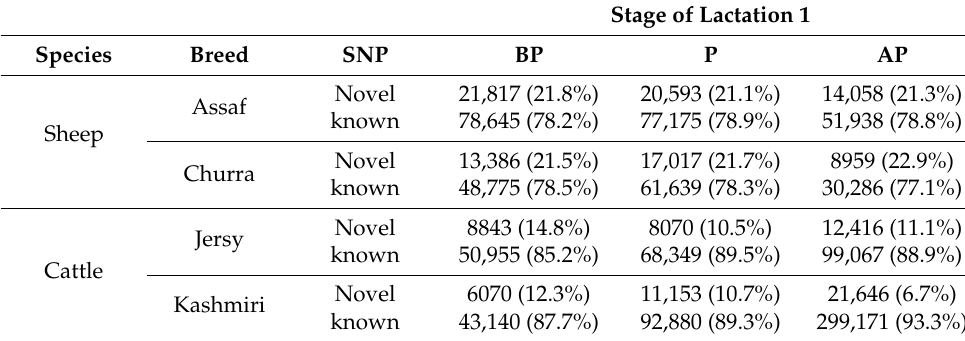
Stage of Lactation 1